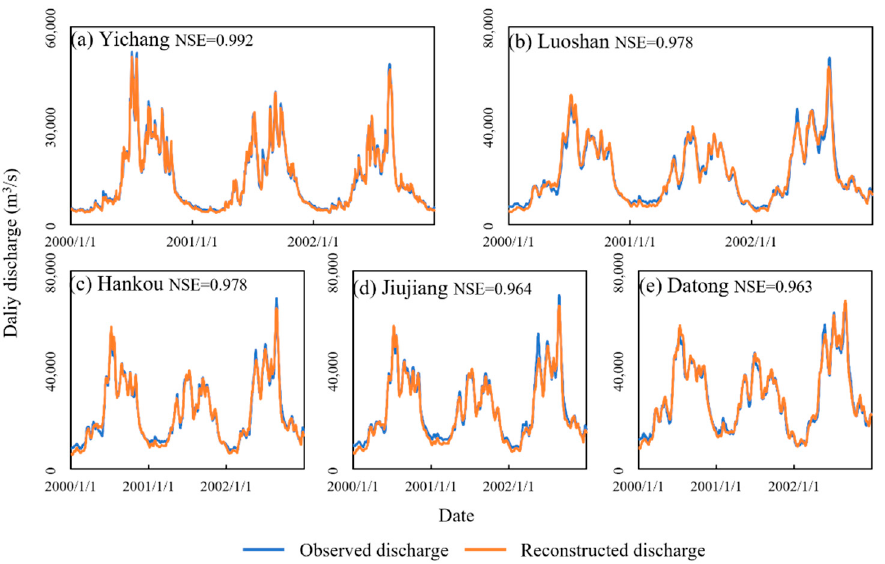
Figure 4. Validation period from 1 January 2000 to 31 December 2002.